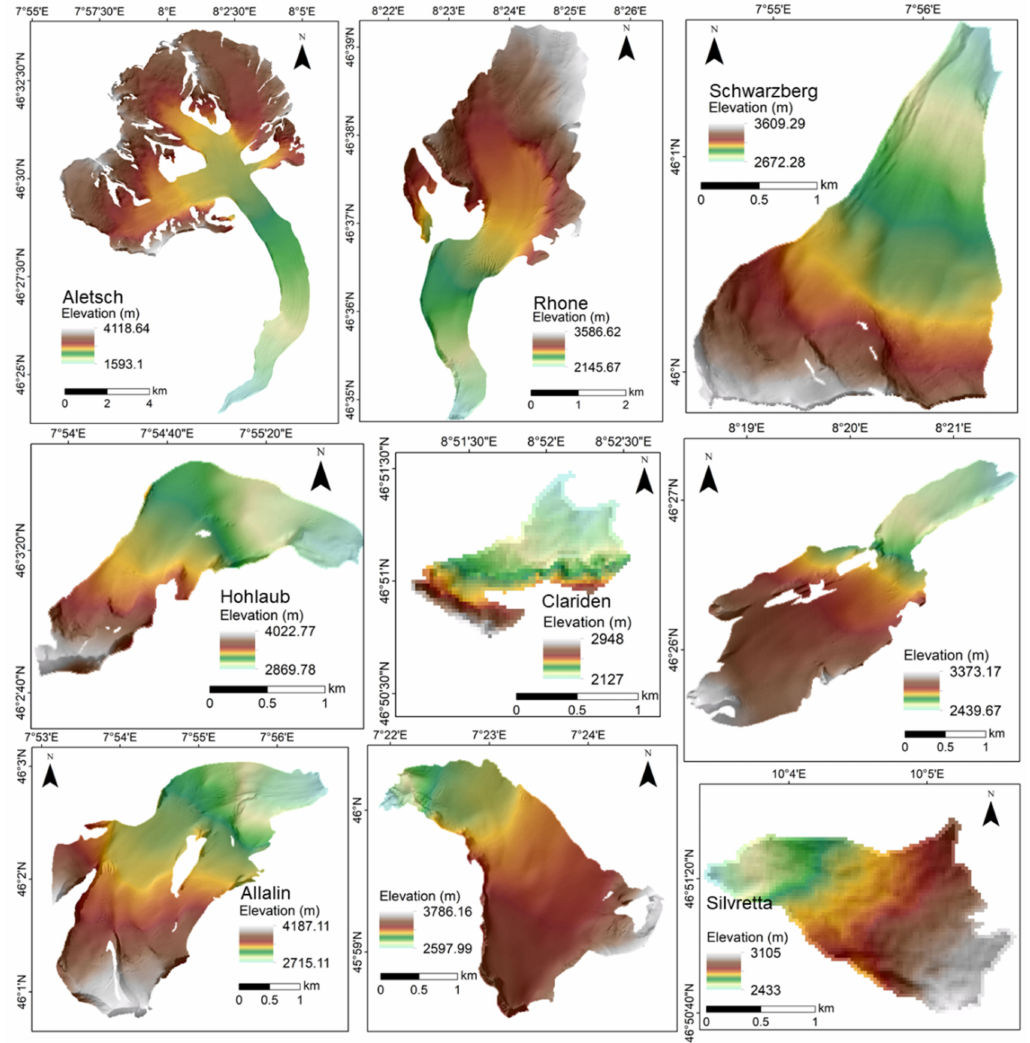
Figure 9. The elevation maps of the selected Swiss glaciers (Sources: swissALTI 3D , and ASTER GDEM V3 for Clariden and